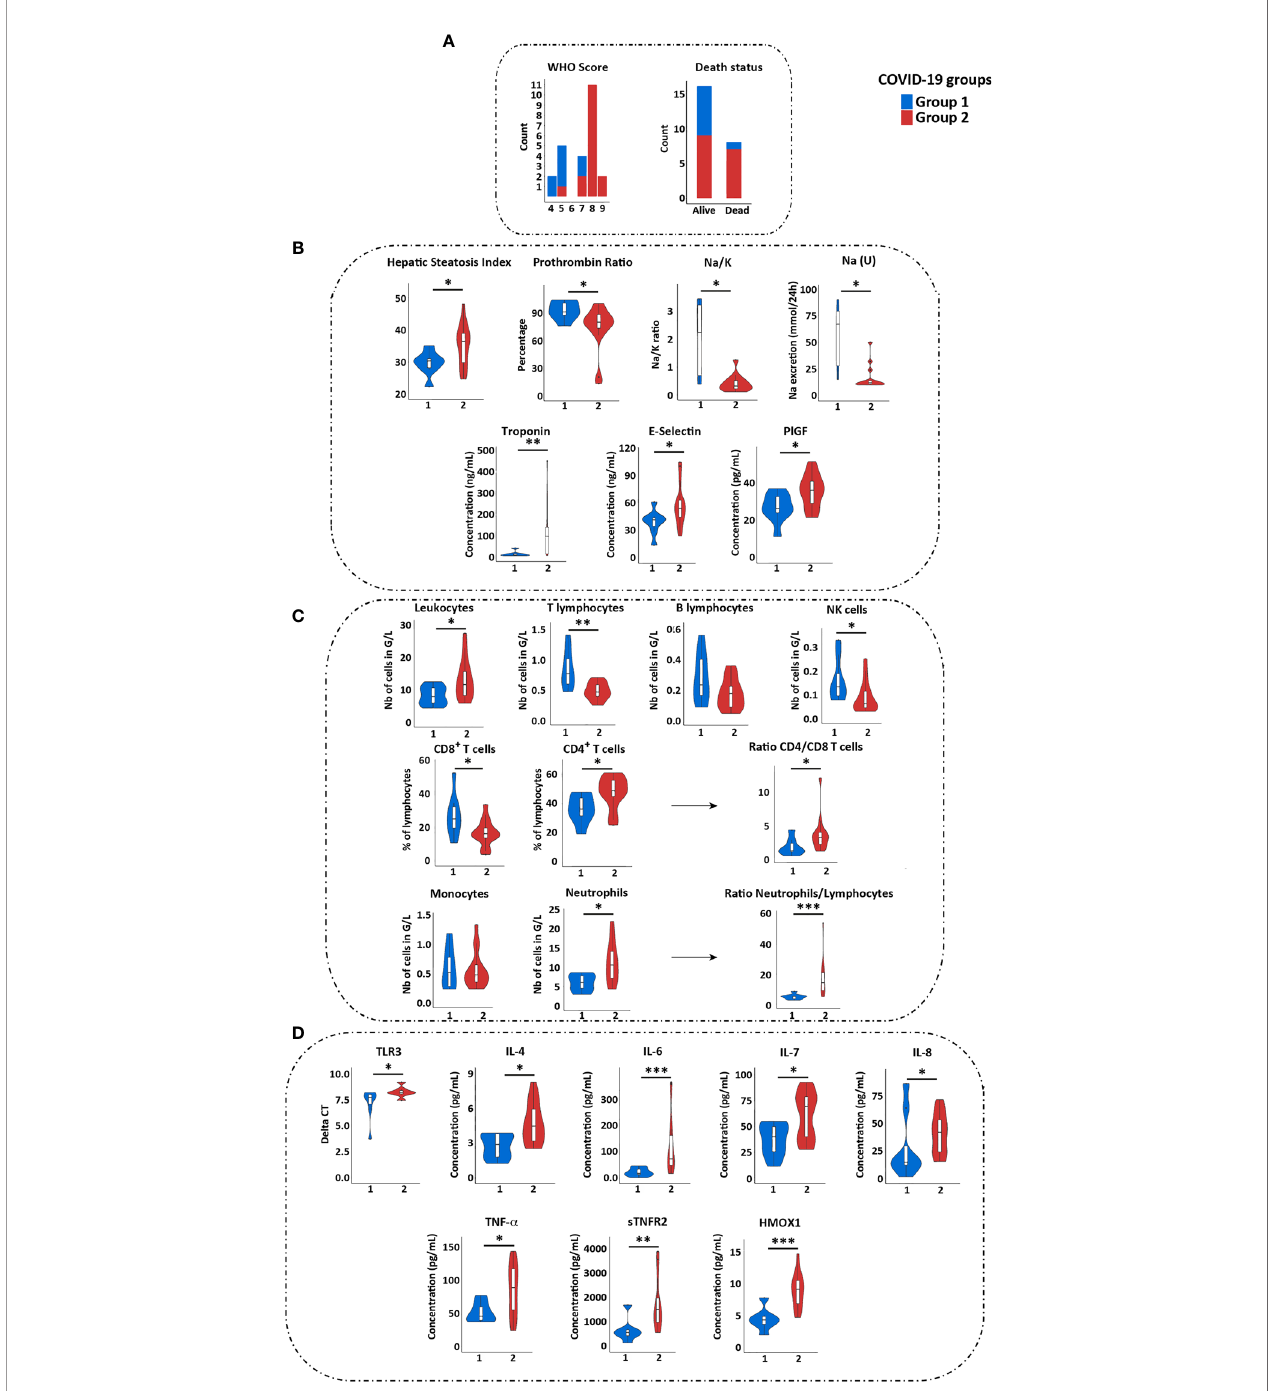
FIGURE 2 | Immune and clinical characteristics of groups 1 and 2 COVID-19 patients. (A) Comparison of WHO score, of need for ICU hospitalization and of death status between group 1 (blue) and 2 (red) patients. (B) Comparison of clinical values re fl ecting liver (HSI and prothrombin ratio), renal [Na/K and Na (U)], cardiac function (troponin), and blood vessels (E-selectin and PIGF) between groups 1 and 2 patients. Only the values showing signi fi cant differences between the two groups are shown. (C) Comparison of immune cells quanti fi cation in groups 1 and 2 patients. (D) Comparison of TLR3 expression and cytokines quanti fi cation in two groups of patients (by Luminex assay). Statistical analyses were performed by Wilcoxon test using GraphPad software. *p < 0.05; **p < 0.01; ***p < 0.001. ICU, Intensive Care Unit; PlGF, Placental Growth